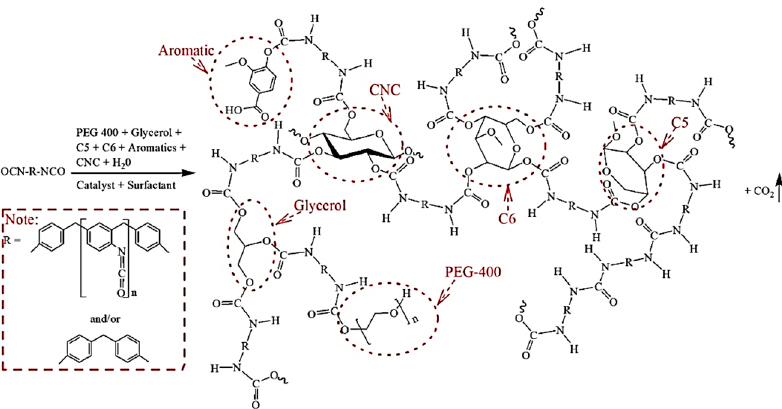
Figure 15. SEM images of bio-foams and cellulose nanocrystals reinforced bio-foams (Adapted from [99] ).